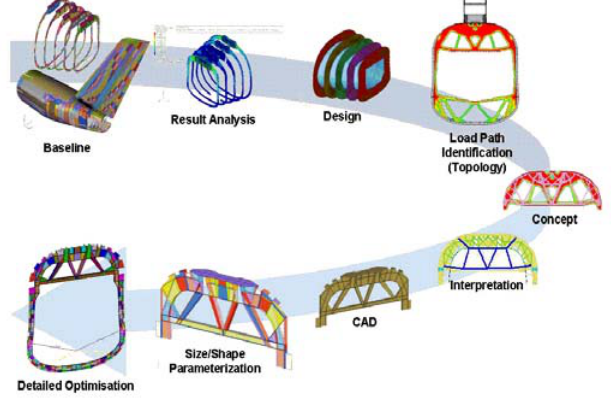
Fig. 9. Example of FE-based detail optimization when chained with topology optimization. A350XWB rear fuse- lage